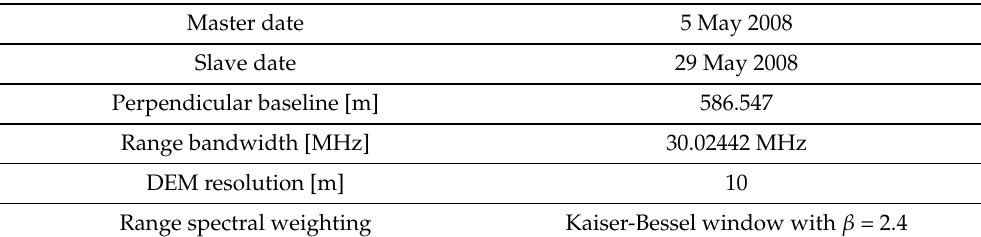
Table 1. Processed interferometric pair